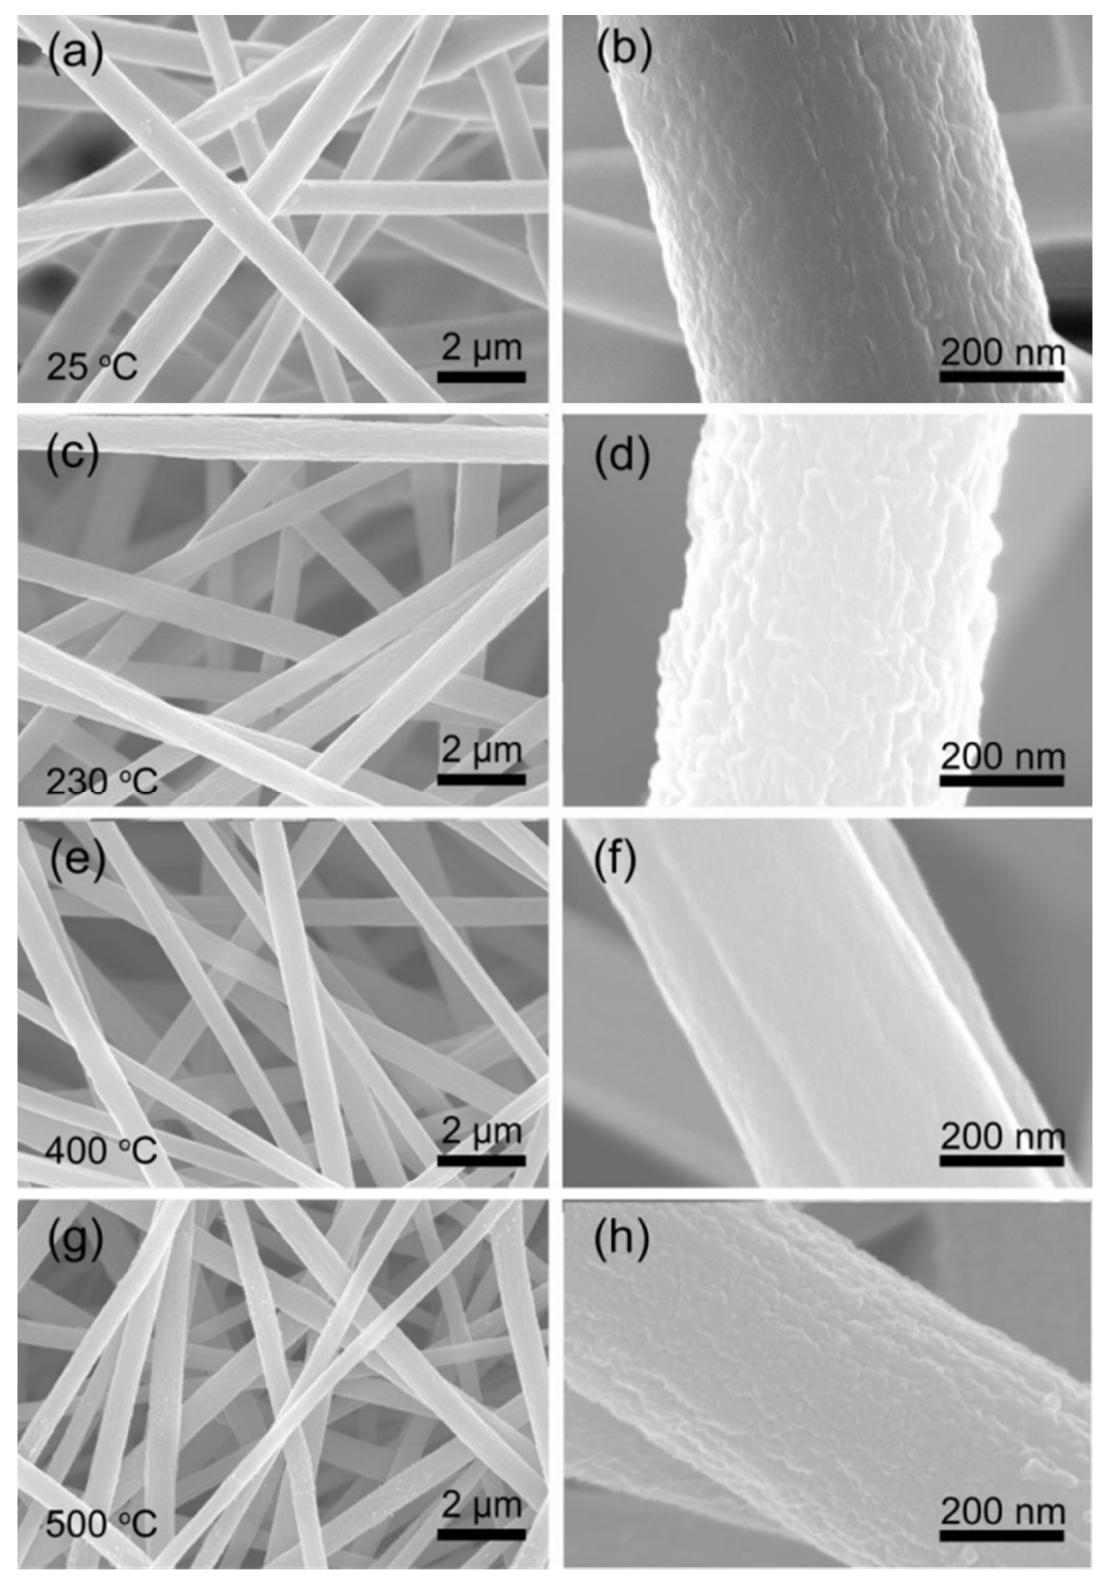
Figure 1. Low magnification and high magnification SEM images of heterogeneous submicron fibers loaded with binary metals and their compounds: ( a , b , 25 °C) CF-P25, ( c , d , 230 °C) CF-P 230, ( e , f , 400 °C) CF-P 400, ( g , h , 500 °C) CF-P 500 samples.